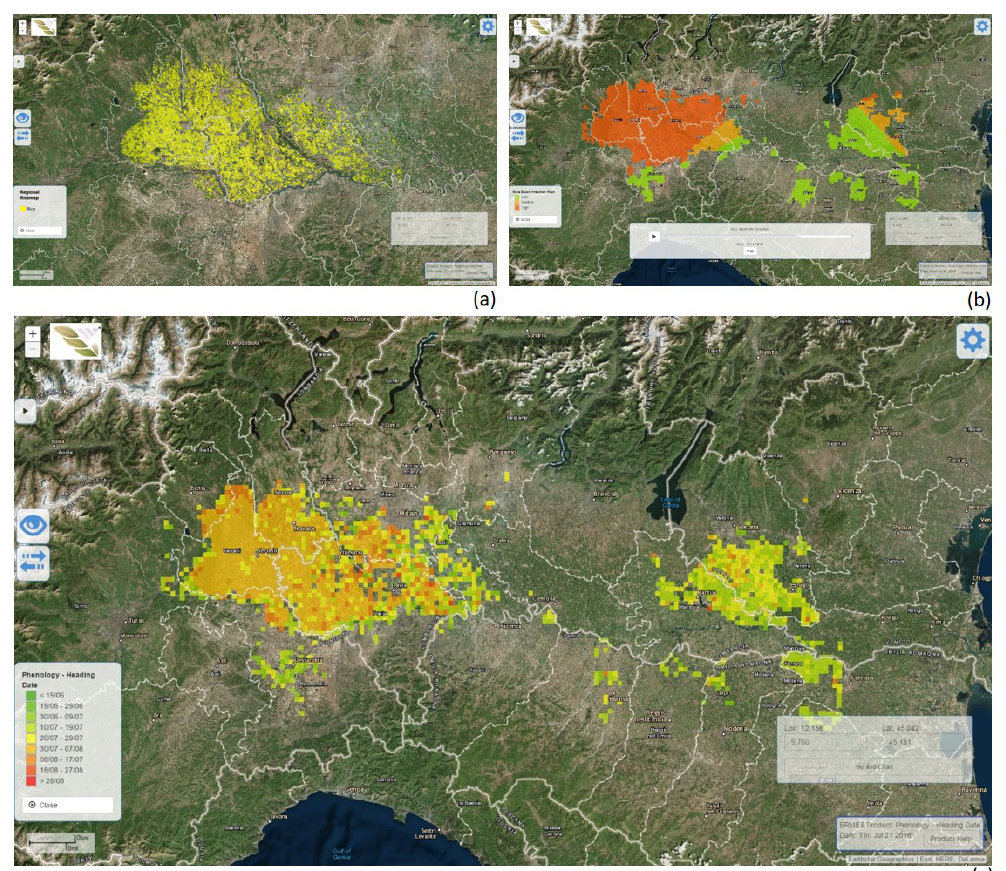
Figure 4. Examples of data products visualization of the Italian study area: ( a ) rice crop map (2016); ( b ) rice blast infection risk map (11 July 2016); ( c ) dates of flowering map (21 July